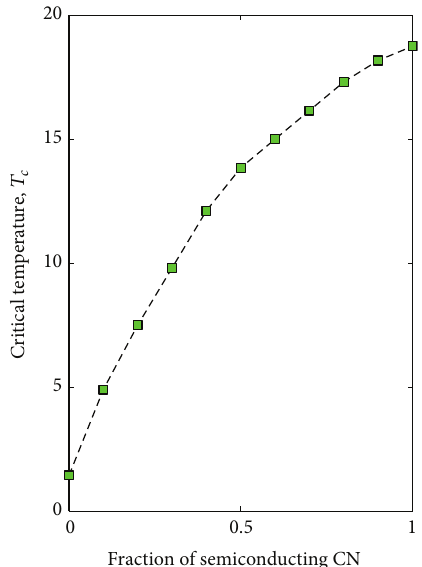
Figure 3: Critical temperature 𝑇 𝑐 as a function of the fraction of doped semiconducting nanotubes 𝑎 . Note a steeper slope for 𝑎 < 0.5 ( 𝑎 = 0.5 is the site percolation limit in two dimensions on a triangular lattice).